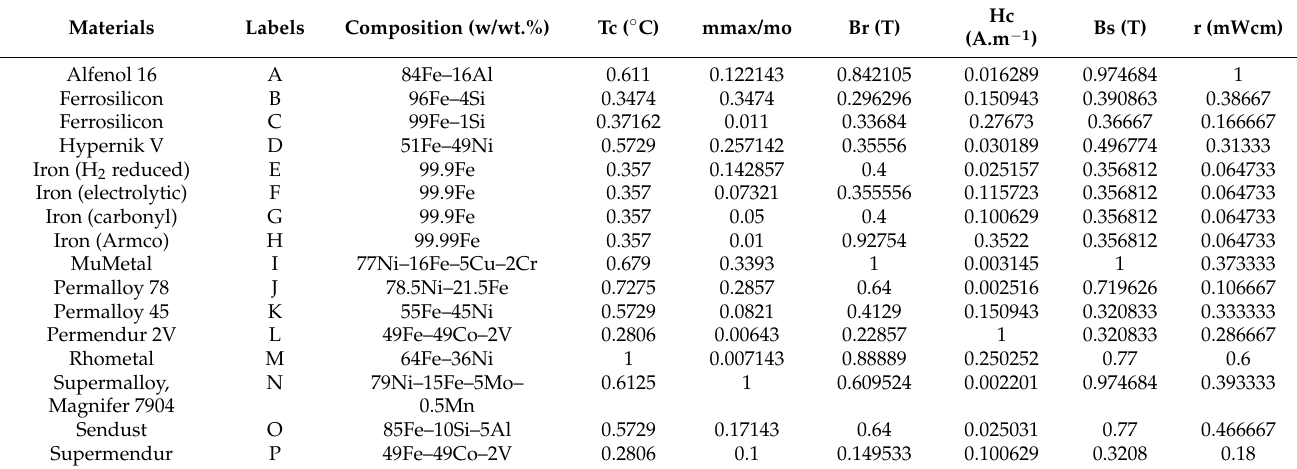
Table 6. Normalized data of soft magnetic material selection attributes.